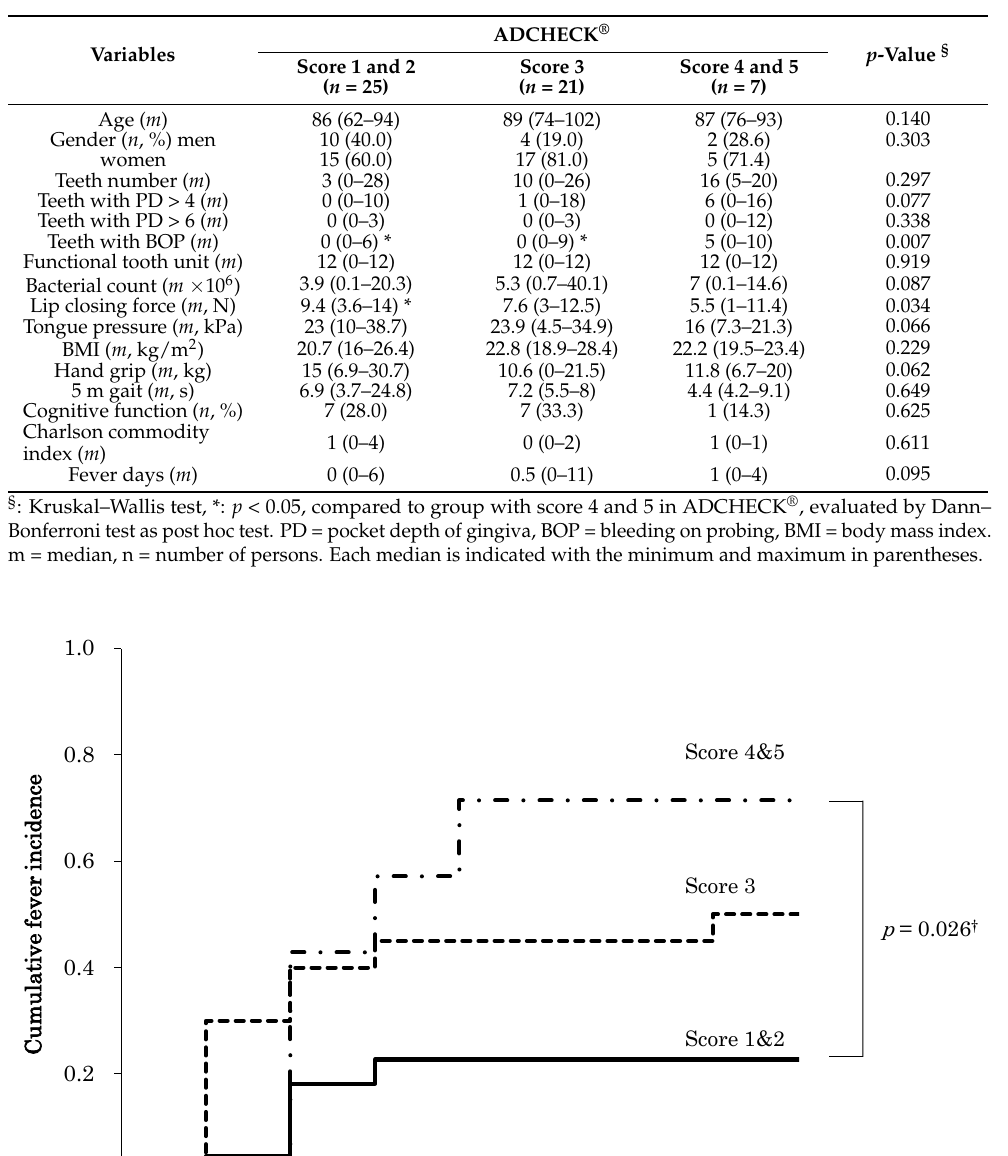
Table 2. Characteristics of each group based on ADCHECK ® scores.